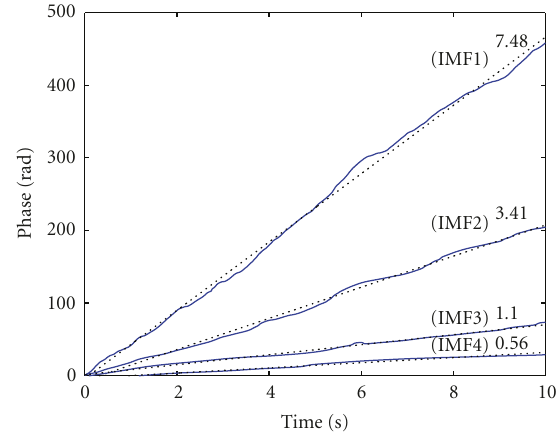
Figure 4: Traces of the instantaneous phase and the value of the average rotation frequency for the first four IMFs of the AP displacement traced in Figure